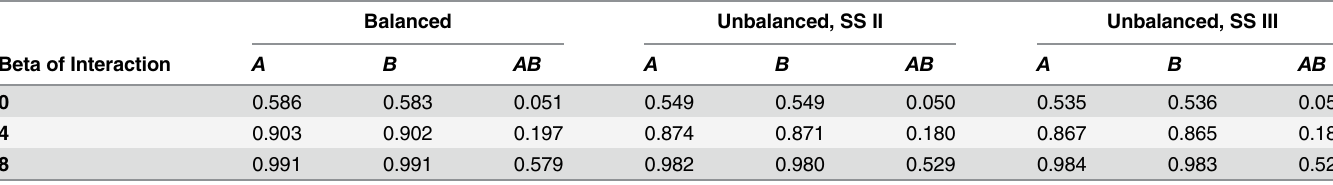
Table 7. Mean rejection rates of H0 (incongruous